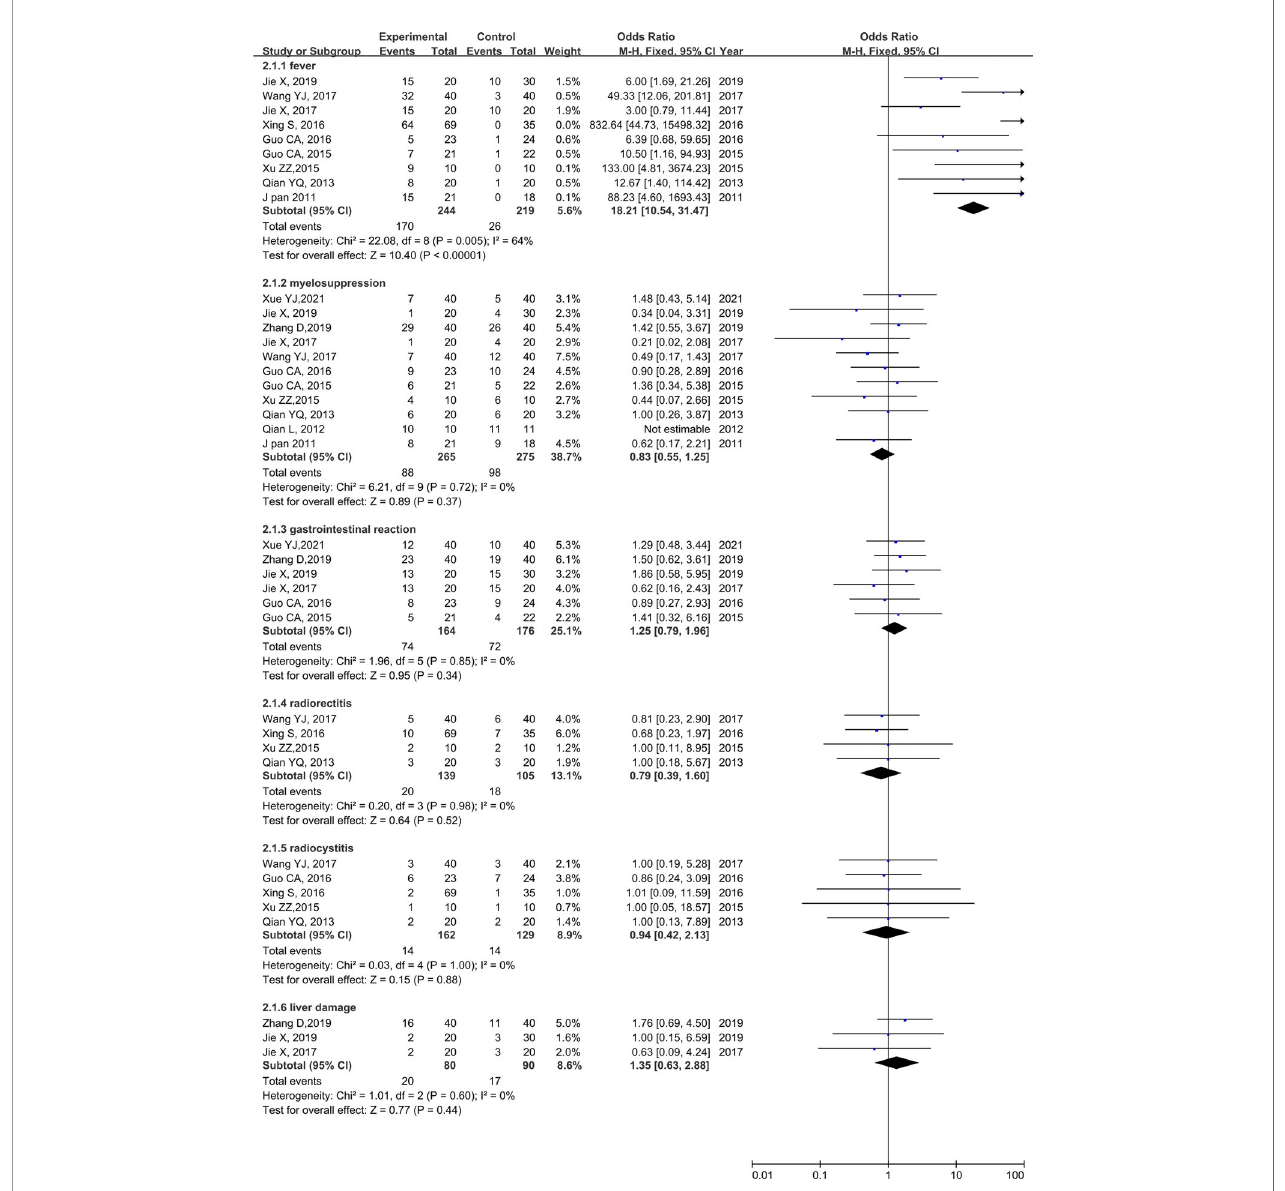
FIGURE 8 | Forest plot for adverse reactions of rAd-p53 combined group and control